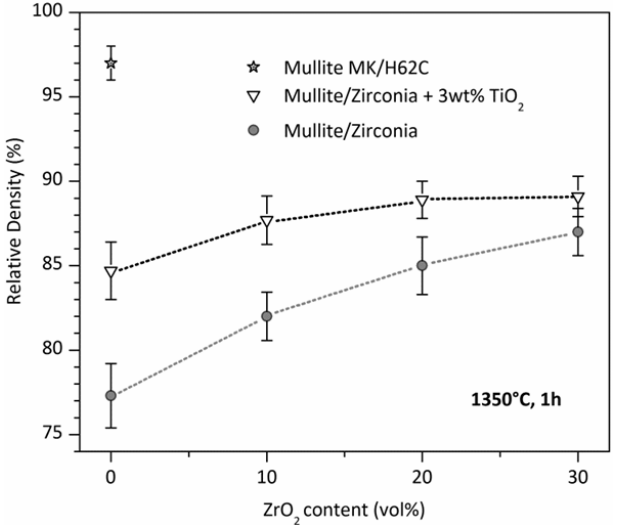
Figure 3. Mullite-based ceramics from MK polymer filled with γ-Al effect of secondary filler (ZrO partial changes in the starting polymer (50% silica provided by MK polymer; 50% provided by H62C